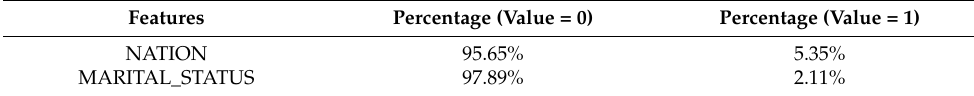
Table 4. Other basic qualitative information about the samples.